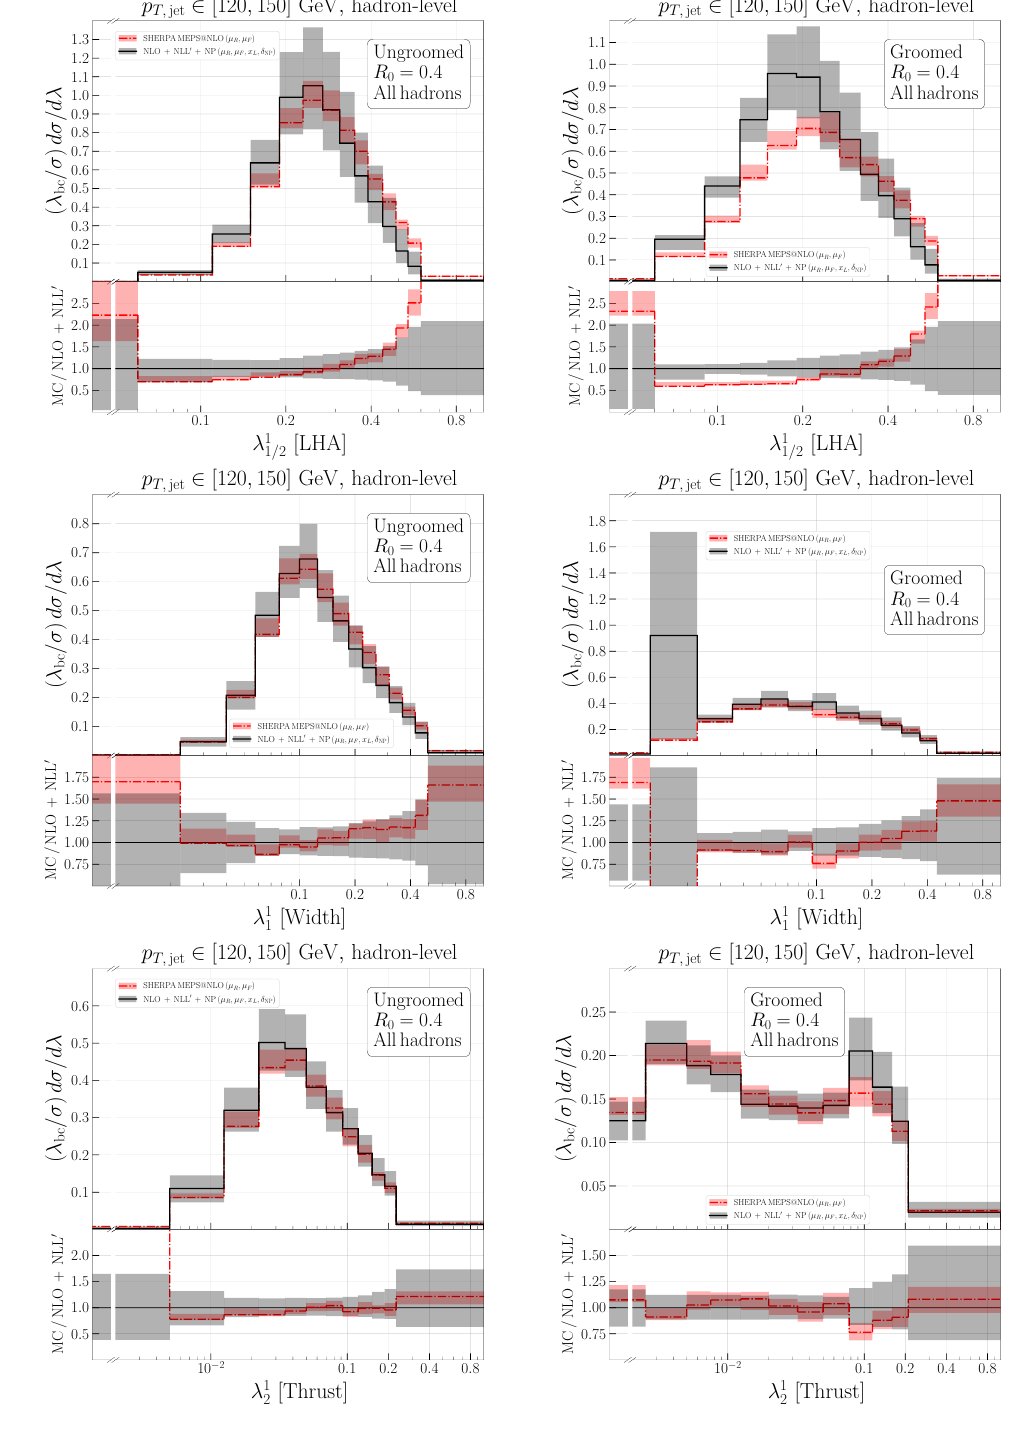
Figure 18 . Same as figure 13 but for R 0 = 0 . 4